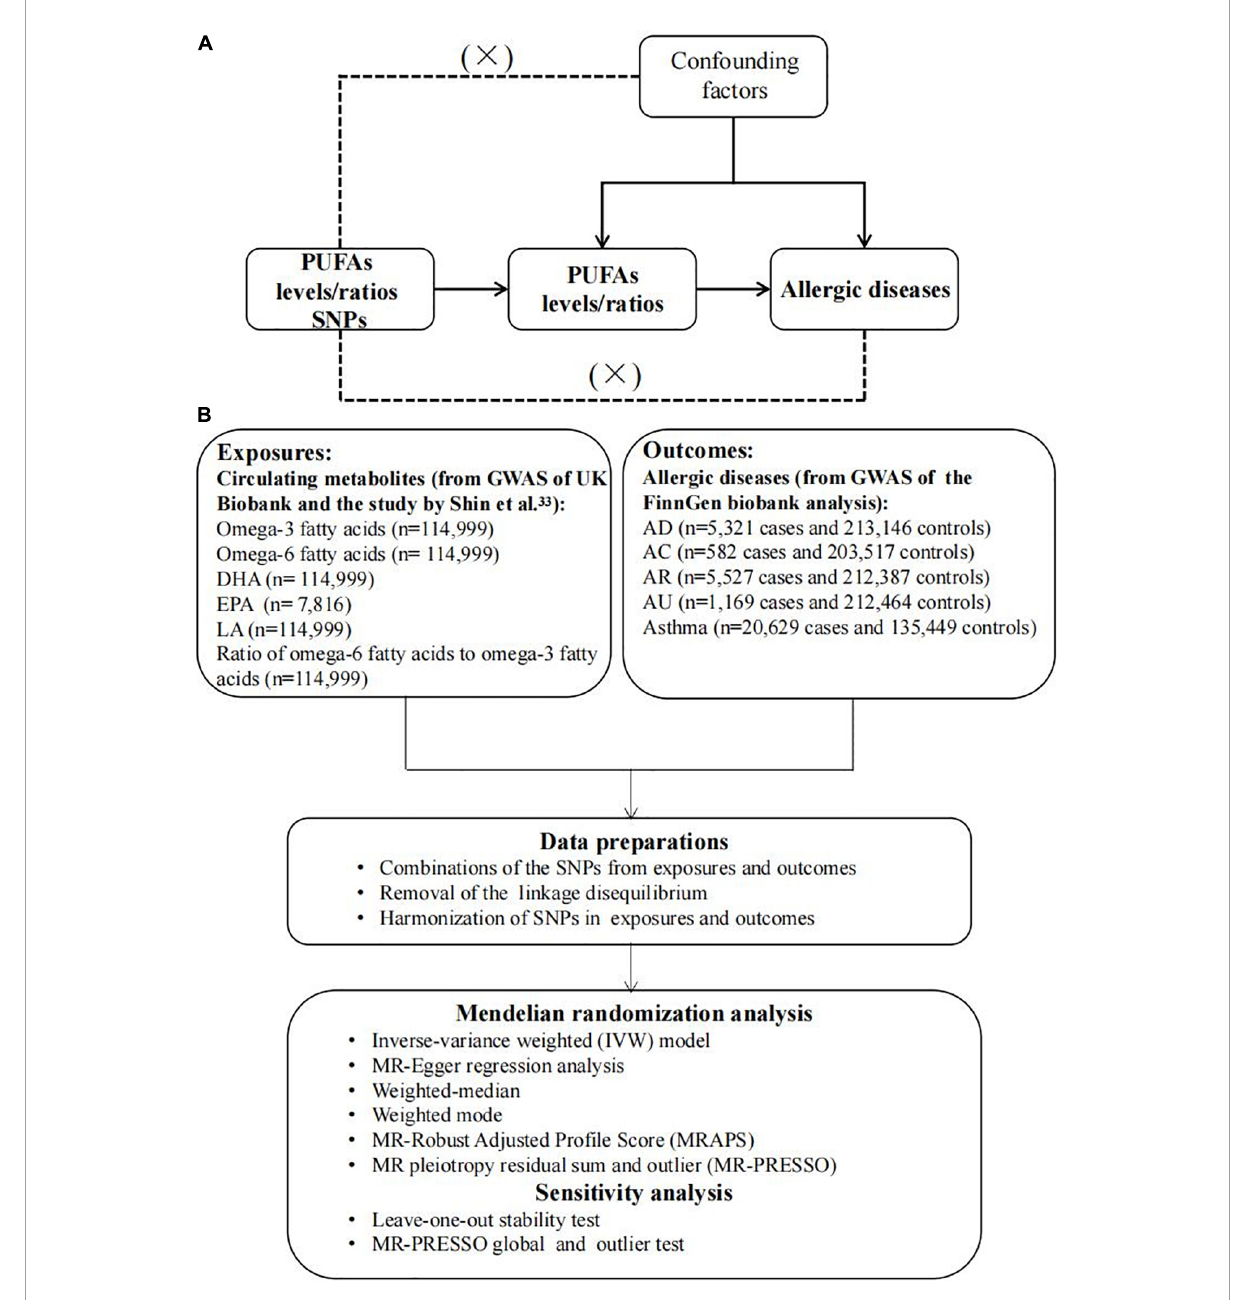
FIGURE1 The overview flowchart of hypothesis and schematic design (A) Mendelian randomization key hypothesis Diagram. SNPs associated with PUFAs levels/ratios were used as the genetic instruments for investigating the causal effect of PUFA on allergic diseases. Line with arrows indicates that the genetic instruments (SNPs) are associated with the exposure and can only affect the outcome via the exposure. Dashed lines indicate that the genetic instruments (SNPs) are independent of confounders between the results. (B) Schematic design for the mendelian randomization